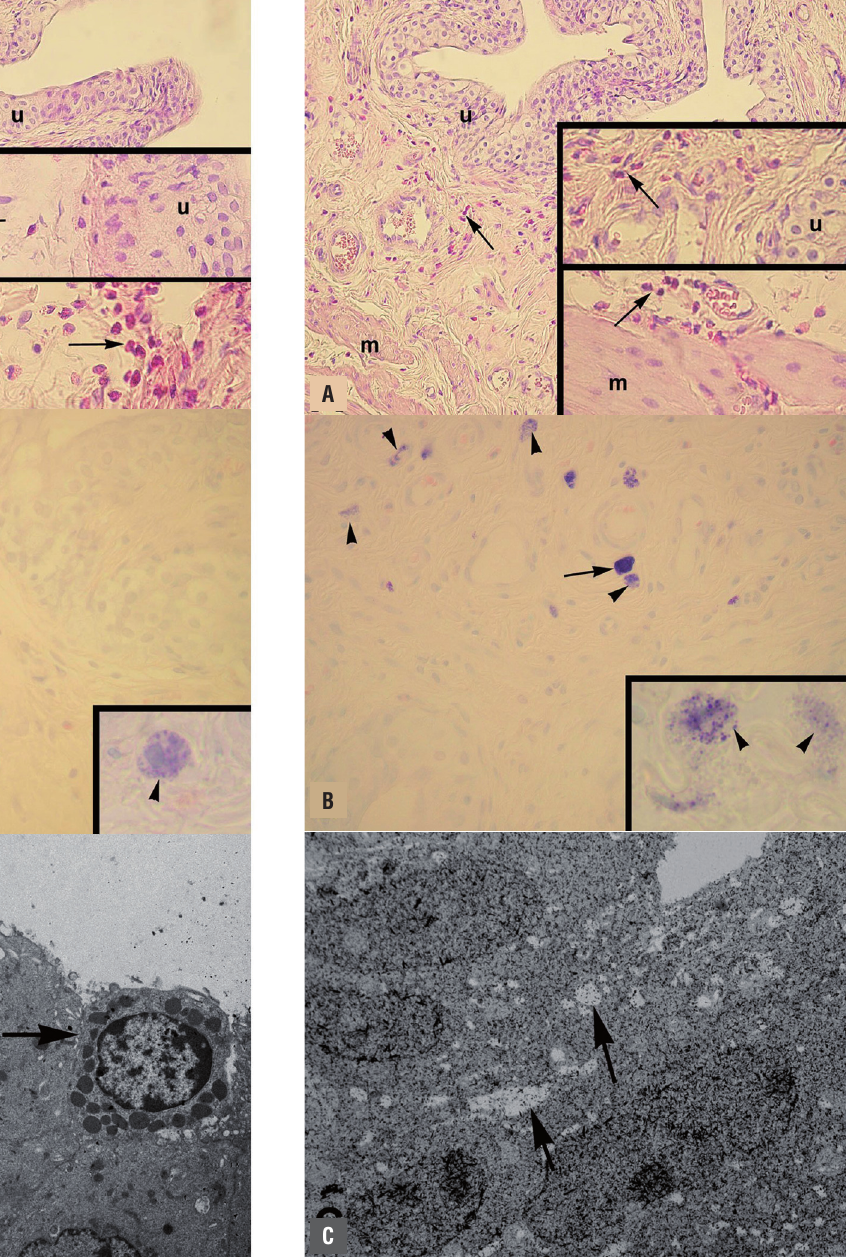
Figure 2 (Group 2) - Regular morphology in urothelium (u), severe inflammatory cell infiltration (arrow) in lamina propria and muscle layers (m) (A), a few both granulated (arrow) and degranulated (arrowhead) mast cells (B) in lamina propria, regular urothelial cells with intercellular spaces and mast cell (arrow) between the urothelial cells (C). A) H&E staining, original magnifications: x100, inserts: x200, B) Toluidine blue staining, original magnification: x400, insert: x1000, C) Electron micrograph, original magnification: X5000.